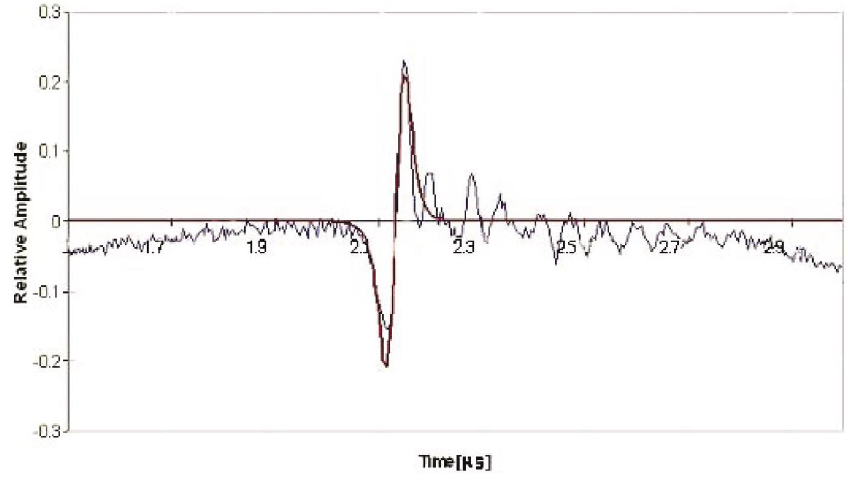
FIG. 22. (Color) Space-charge wave in NTX for a low-current